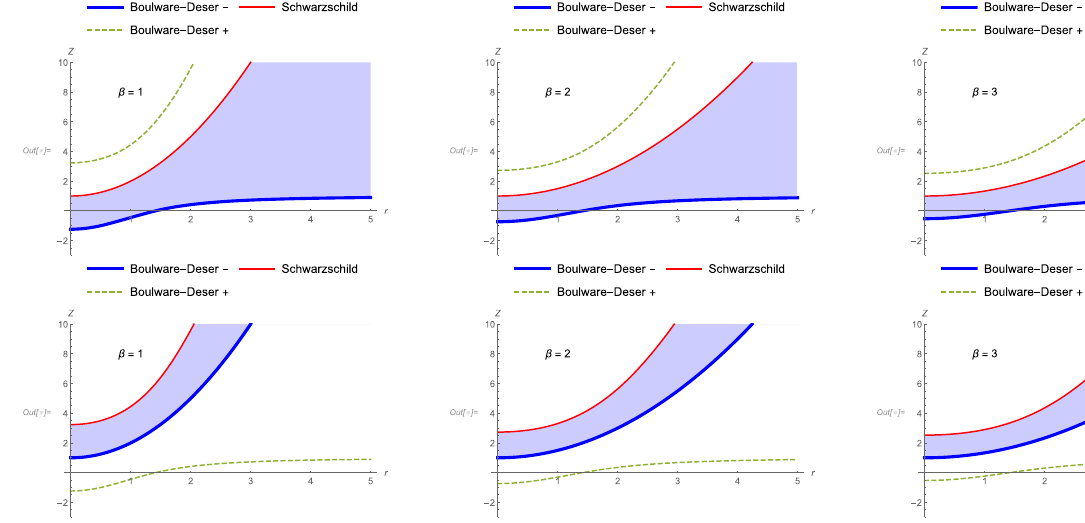
Fig. 2 Plots of feasible spatial potential regions for C 1 =